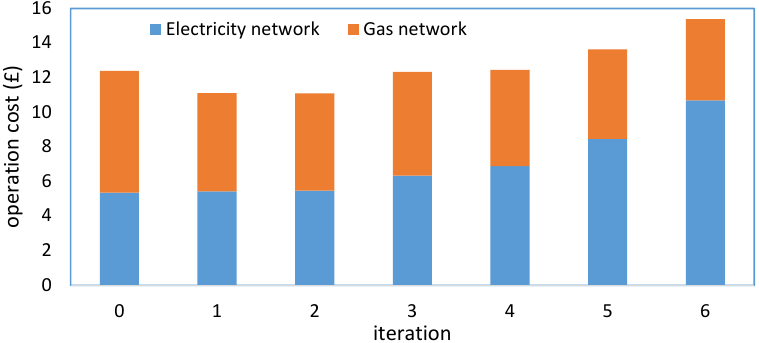
Figure 6. Comparison of network costs in six iterations in separated Method.